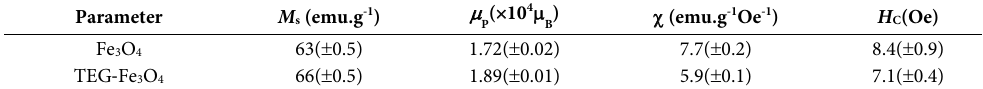
), average core superspin ( µ s